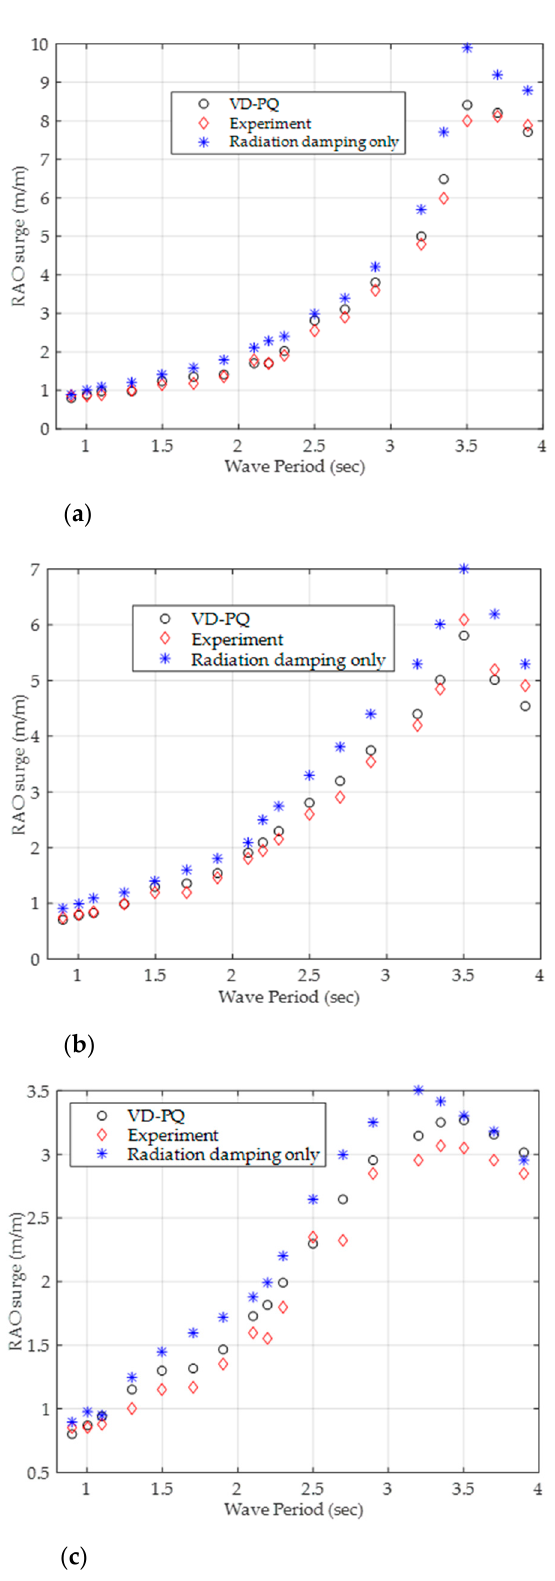
Figure 8. Comparison of surge motion of the examined WEC between experimental data and predictions with use of the VD-PQ viscous damping and with use of potential theory damping for ( a ) wave height equal to 12 mm, ( b ) wave height equal to 25 mm and ( c ) wave height equal to 75 mm.